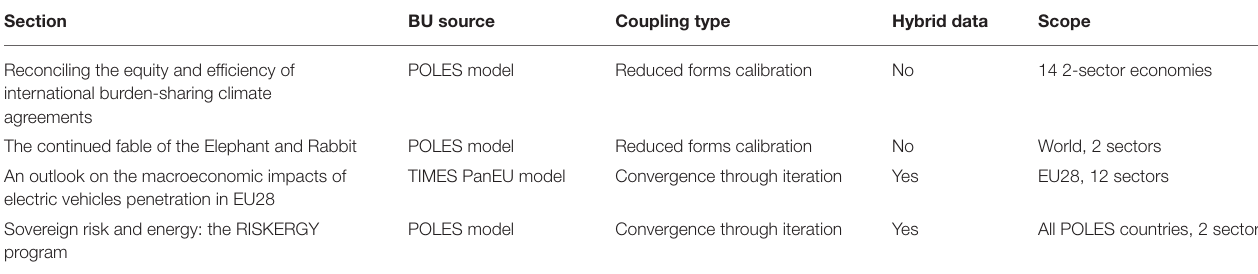
TABLE 1 | The settings of 4 hybrid modeling experiments involving IMACLIM-S.